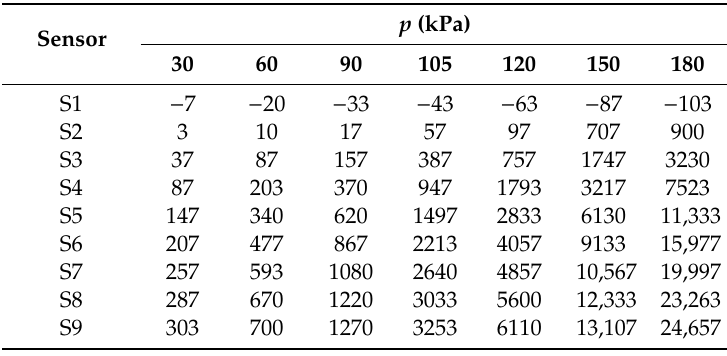
Table 1. The measured strain of each sensor for E9 (unit: µε ).